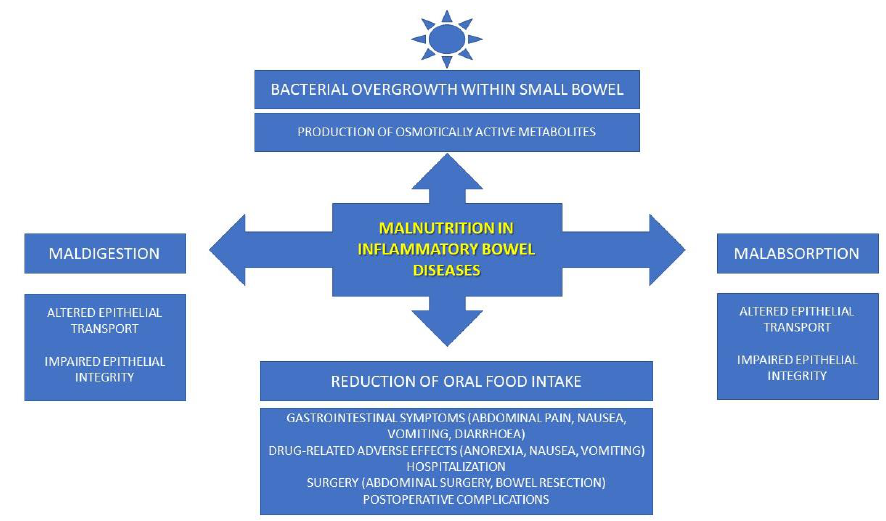
Figure 2. Pathomechanisms of malnutrition in IBD patients.